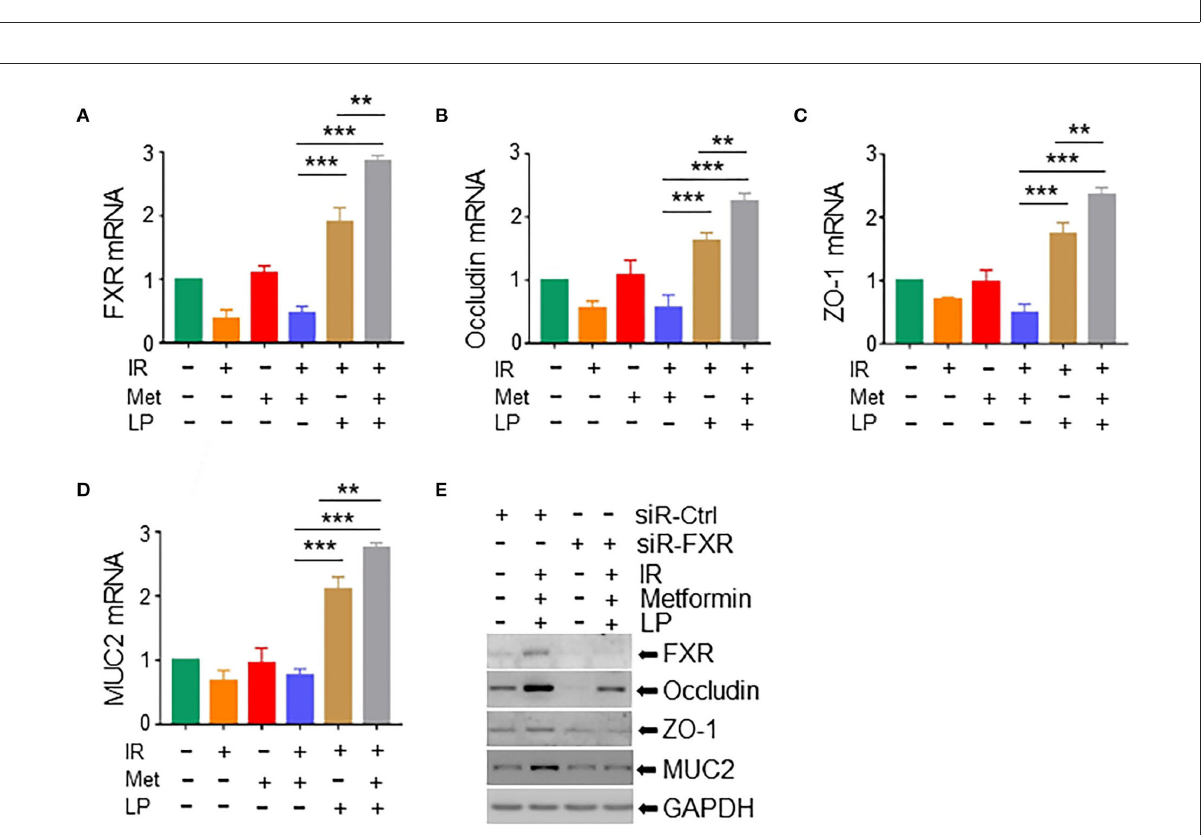
FIGURE6 Metformin/ Lactobacillus exerts a radioprotective effect via activating the FXR signaling. Intestinal organoids were treated with metformin and/or Lactobacillus as described in the Materials and methods section and Figure 5. Organoids were irradiated with 8-Gy X-ray. Total RNAs or whole cell lysates were extracted from the intestinal organoids 16h after the irradiation. mRNA levels of FXR (A) , occludin (B), ZO-1 (C) , and MUC2 (D) in intestinal organoids. qPCR was used for the quantitation. (E) Expressions of FXR, occludin, ZO-1, and MUC2 in intestinal organoids with FXR knockdown were detected with Western blotting. Data represent mean ± SEM. ** P < 0.01, *** P < 0.001, n = 5, compared with metformin +